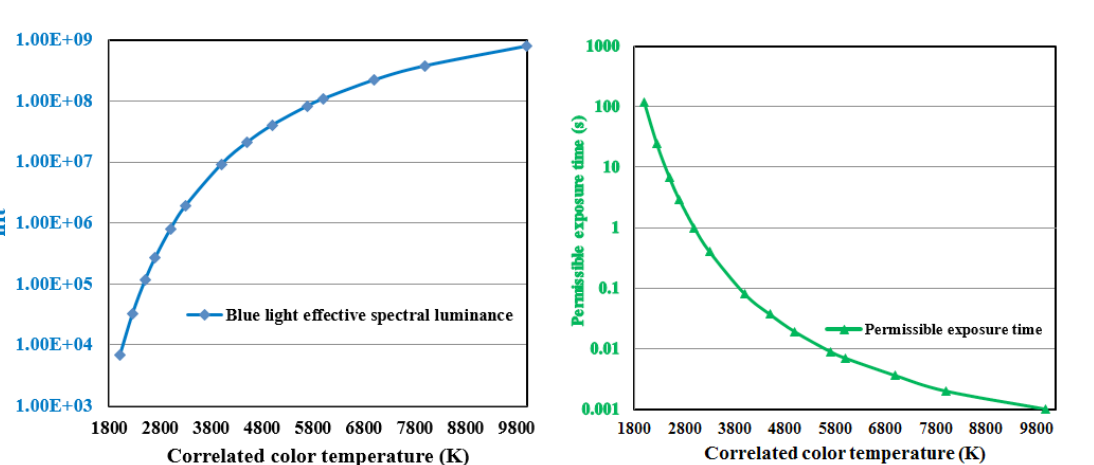
Figure 8. Estimated Effective Spectral Luminance (Left) and Estimated Permissible Exposure Duration (Right), Using Proposed Photometry Method for the CCT Range of 2000-10000 K